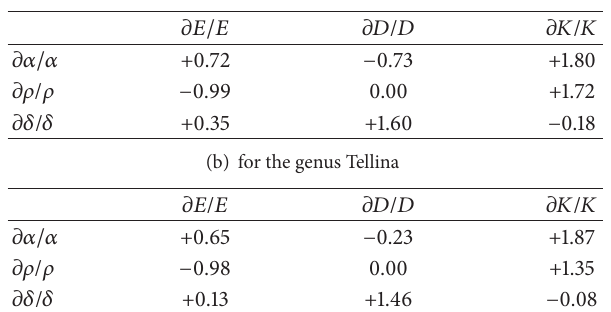
parameters 𝛼 , 𝜌 , 𝛿